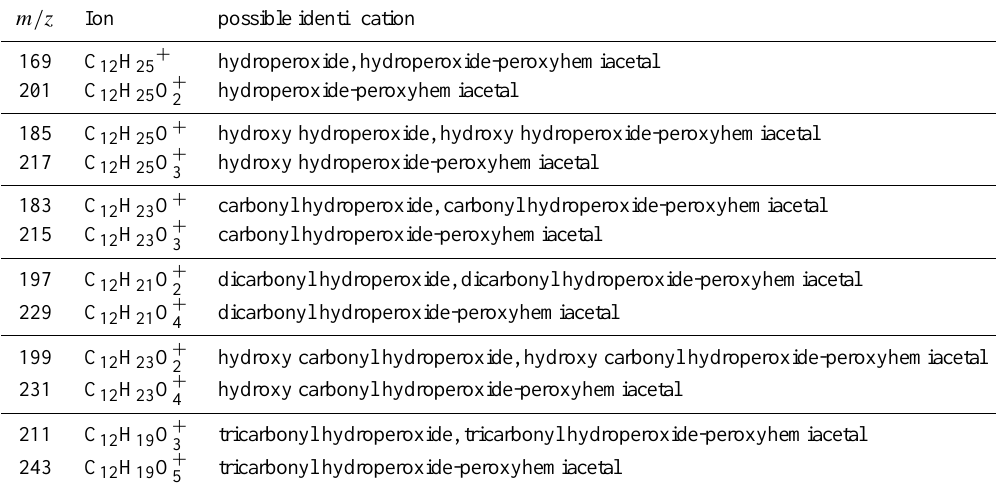
Fig. 8. Factor time series with the top three highest Pearson’s r correlating HR-ToF-AMS ions. Table 2. Ion